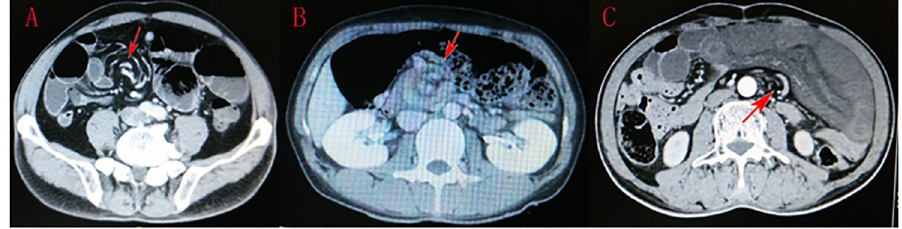
Fig 1. Contrast-enhanced abdominal CT demonstrated the dilation of small bowels and whirl-like pattern of distended small bowels encircling the mesenteric arteryor its branches (red arrows).